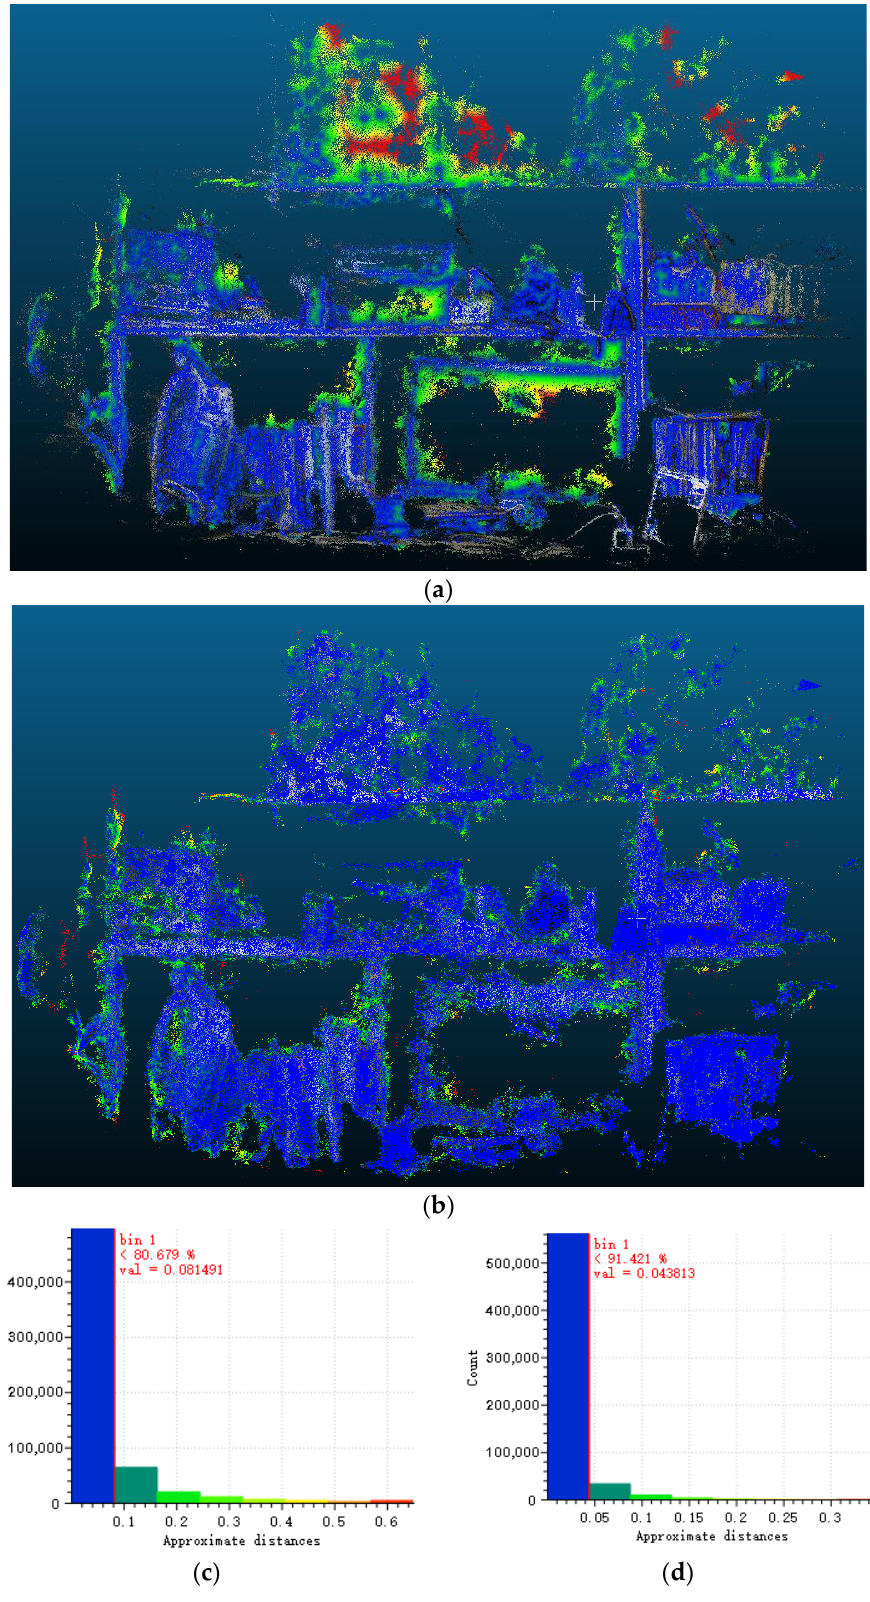
Figure 24. Cloud-to-cloud distance result. ( a ) Compared cloud: CES-MVSNet. Reference cloud: traditional method; ( b ) compared cloud: CES-MVSNet. Reference cloud: MVSNet; ( c ) histogram of the compared cloud in ( a ); ( d ) histogram of the compared cloud in ( b ).